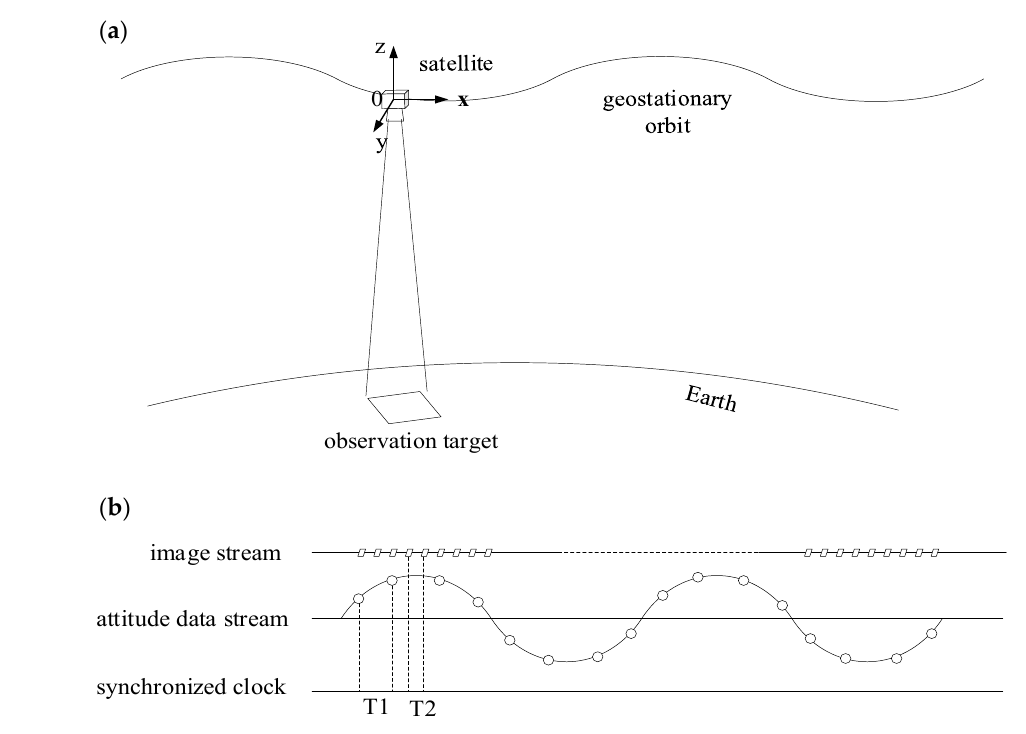
Figure 1. Satellite remote-sensing imaging system. ( a ) Schematic diagram of the geostationary orbit satellite imaging system; ( b ) schematic diagram of mismatch between discrete attitude data of sine law and discrete image data.